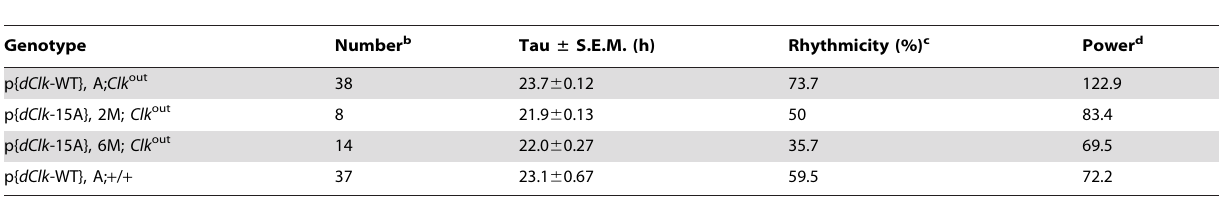
Table 3. Behavioral analysis of p{ dClk -15A}; Clk out flies following temperature cycles. a